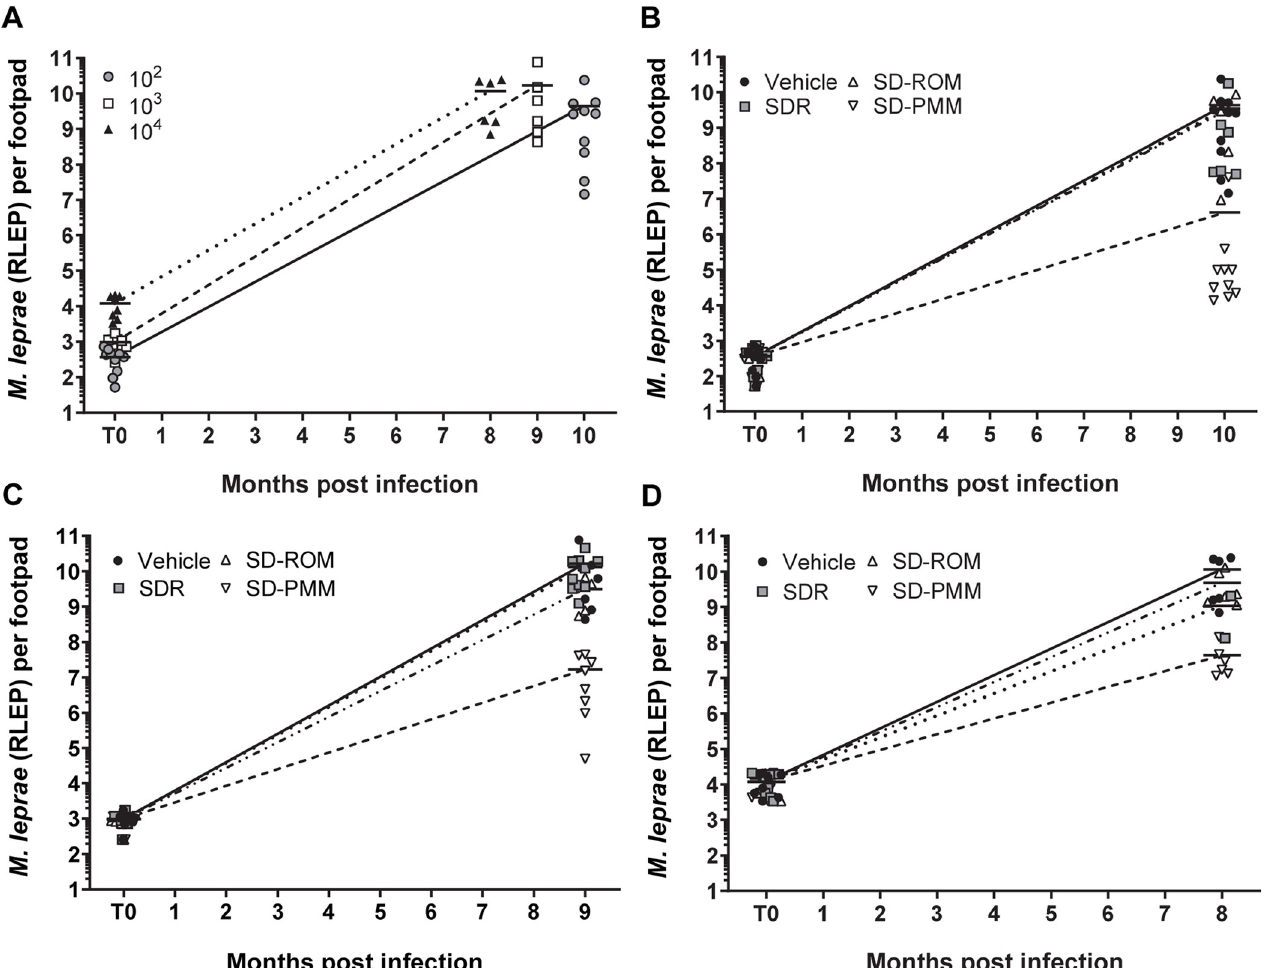
Fig 1. Single dose PEP regimens are unable to control M . leprae growth regardless of baseline levels of bacilli. Athymic nude mice were infected in both hind footpads with 6 x10 3 M . leprae . Mice were treated with single dose rifampin (SDR), single dose ROM (rifampin, ofloxacin, minocycline), or single dose PMM (rifapentine, moxifloxacin, minocycline) at 1 day, 1 month, or 2 months post-inoculation. M . leprae were enumerated by RLEP qPCR. (A) Comparison of growth of the vehicle groups at all initial infectious doses (10 2 , 10 3 , and 10 4 bacilli). Comparison of growth at (B) 10 2 bacilli, (C) 10 3 bacilli, and (D) 10 4 bacilli. Bars represent the mean for each